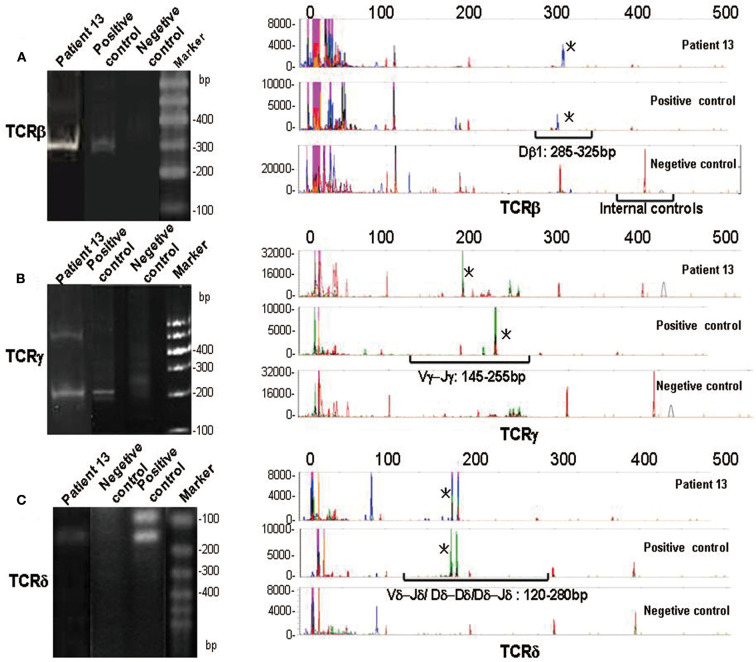
PCR analysis of TCR gene rearrangements. Heteroduplex analysis (left panel) and GeneScanning (right panel) of patient 13, negetive controls, and positive controls. The negetive controls show a vague smear in heteroduplex analysis and a complex peak pattern in GeneScanning. The red peaks indicate housekeeping genes (internal controls). The positive controls and patient 13 show visible bands in heteroduplex analysis and monoclonal peaks (marked with asterisk) in GeneScanning in approximate position of molecular weight. (A) Analysis of TCRβ gene rearrangements (monoclonal peaks are located in Dβ1 gene segments: 285–325 bp). (B) Analysis of TCRγ gene rearrangements (monoclonal peaks are located in Vγ- Jγ gene segments: 145–255 bp). (C) Analysis of TCRδ gene rearrangements (monoclonal peaks are located in Vδ-Jδ/Dδ- Dδ/Dδ- Jδ gene segments: 120–280 bp).